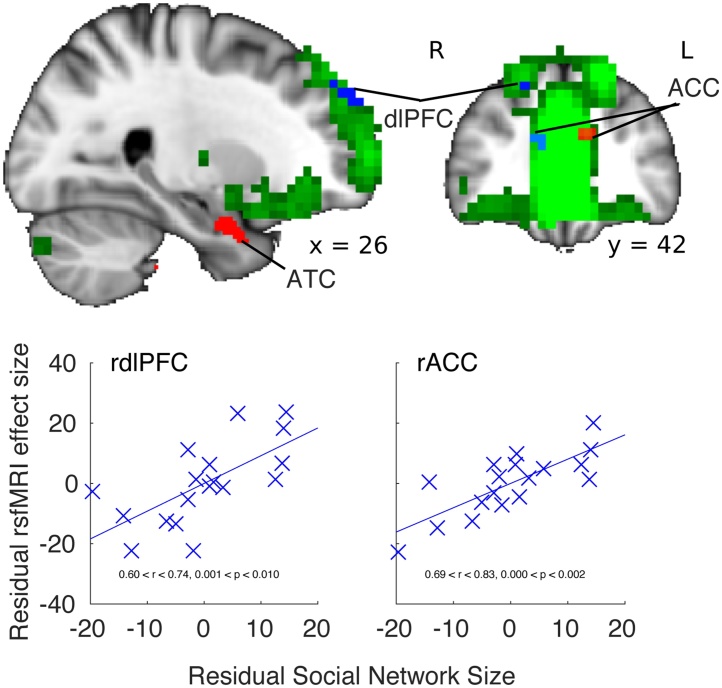
Dual regression results showing regions (blue, SVC p < 0.05) that are increasingly recruited into the aDMN (green) when subjects report larger social networks. VBM results are shown on slices for reference (red). Scatter plots illustrate the residual effect sizes against the residual of SNS taken from ROIs (64 mm3) placed at the centre of gravity of significant clusters, after accounting for age, gender and years of education. Images are in radiological convention. Abbreviations: dlPFC dorsolateral prefrontal cortex, ACC anterior cingulate cortex, ATC anterior temporal cortex. (For interpretation of the references to colour in this figure legend, the reader is referred to the web version of this article).